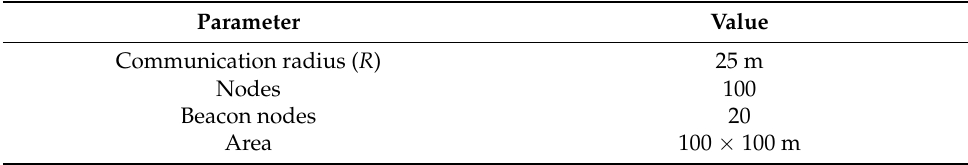
Table 1. Experimental parameter settings.